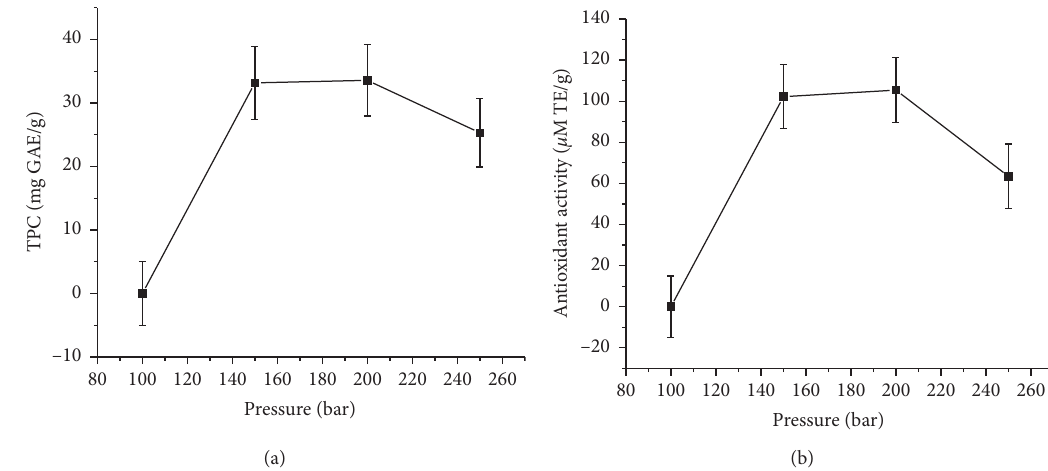
Figure 4: Effect of pressure (bar) on the (a) TPC (mg GAE/g) and (b) antioxidant activity ( μ M TE/g) of the extract.